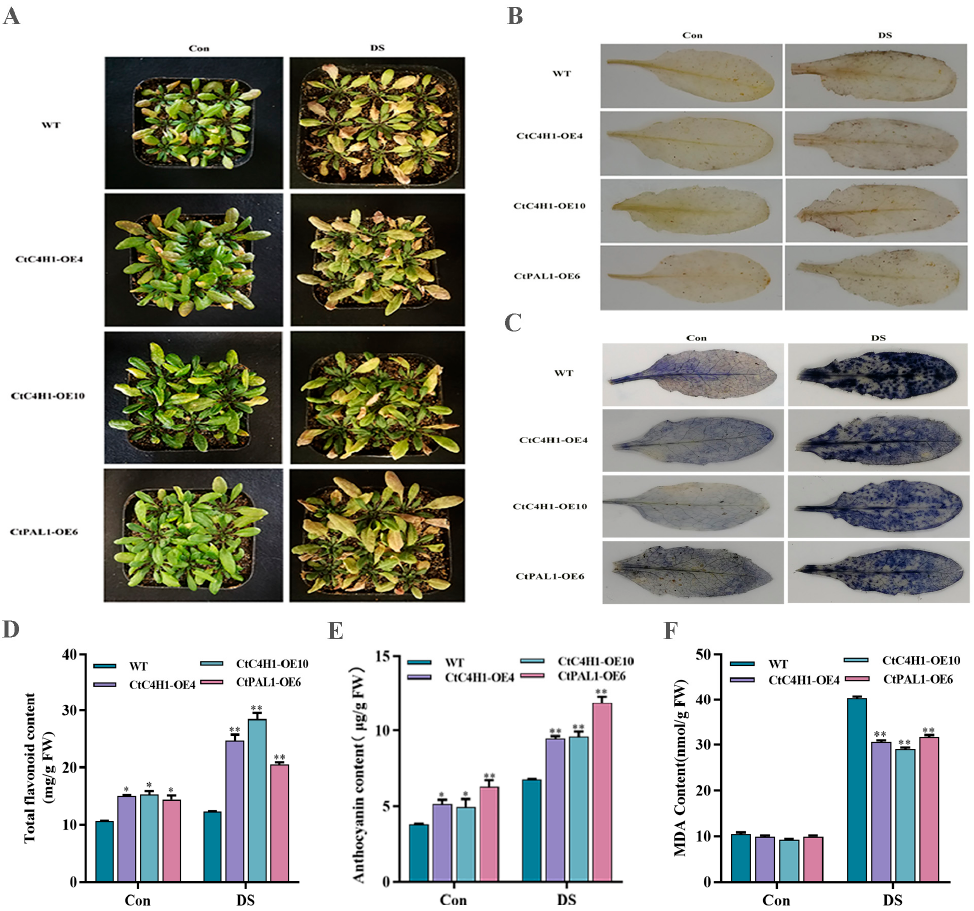
Figure 8. Leaves phenotypic and biochemical analysis of CtPAL1 and CtC4H1 transgenic plants after DS (drought stress) treatment. ( A ) Phenotype of transgenic plants after 14 days of drought stress treatment. ( B ) DAB staining assay, leaves were stained with DAB after drought treatment. ( C ) NBT staining assay, leaves were stained with DAB after drought treatment. ( D ) Total flavonoid content. ( E ) Anthocyanin content. ( F ) Malondialdehyde. (MDA) content analysis. The numerical value represents the average ± standard deviation of three biological repetitive samples. The statistics were calculated with one-way ANOVA test and significant differences between treatments were demonstrated with asterisk (* p < 0.05, ** p < 0.01).